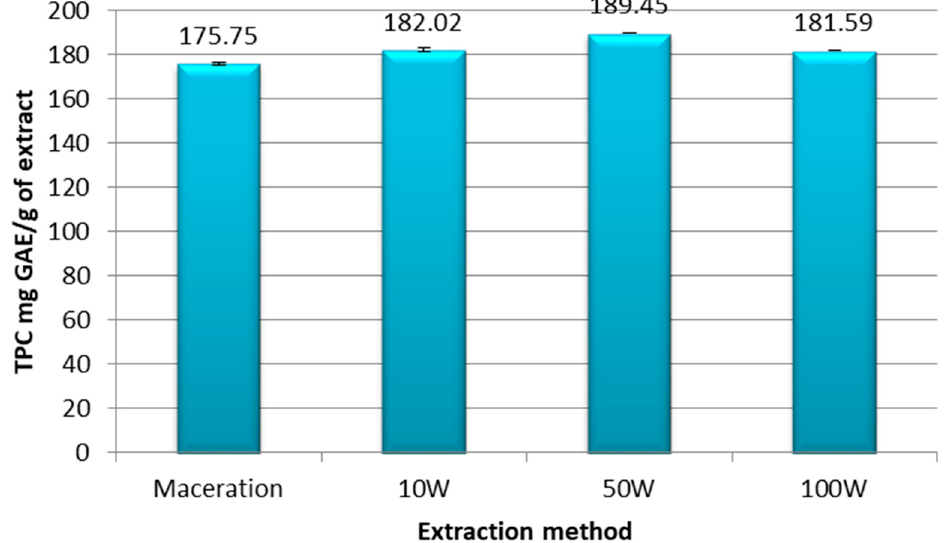
Figure 2. Total phenolic compounds expressed in mg GAE/g extract of ethanolic extracts of pomegranate peel obtained by maceration or ultrasound at a power of 10 W; 50 W; and 100 W. Experiments were repeated three times ( n = 3). Bars display mean ± S.D.